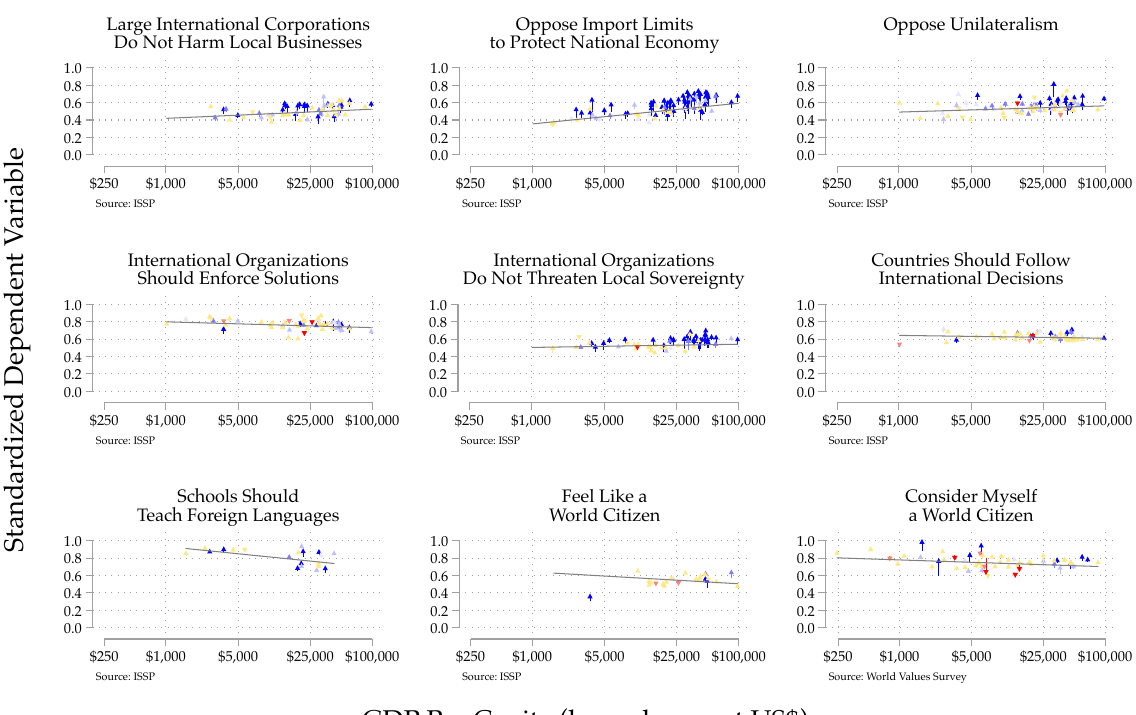
Figure 1: Quiver plots illustrating the effect of urban professional elite status on cooperative-internationalist attitudes using results of country-wave level regressions on global survey data. Note: This figure displays results of 714 individual linear models regressing urban professional elite status on each dependent variable for each country-wave in the global surveys. The gray fit line tests H1 by illustrating the relationship between GDP per capita and the mean value of each dependent variable (scaled to range from 0–1) for a given country-wave. Colored arrows test H2 and H3, with standardized regression coefficients on the y axis indicating the proportion change in the dependent variable associated with urban professional elite status in each country-wave. Blue arrows indicate positive and significant coefficients, red arrows indicate negative and significant coefficients, and yellow arrows indicate coefficients that do not achieve statistical significance at the p < 0.05 level. Darker shades indicate smaller p